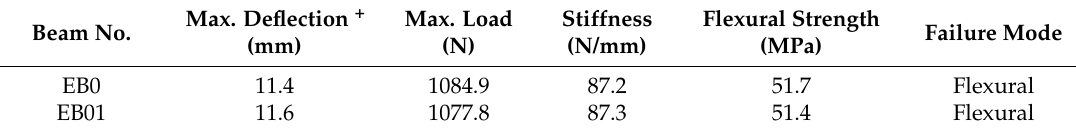
Table 2. Test results of the epoxy control beam specimens.